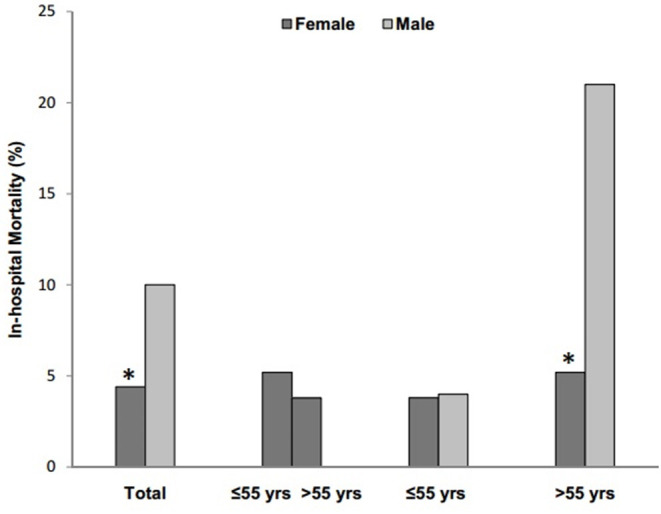
Sex-specific in-hospital mortality of COVID-19 patients and subgroup stratified by age of 55 years. * P < 0.05 vs. male by chi-squared tests or Fisher's exact tests.